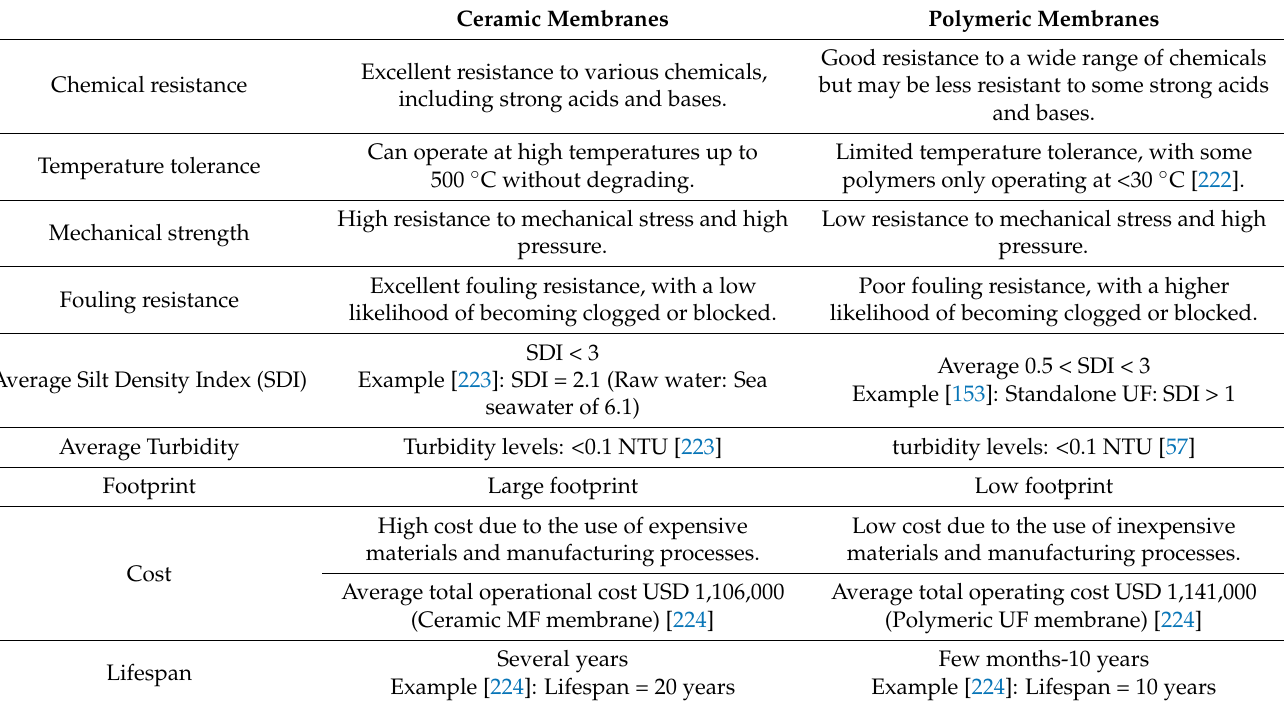
Table 9. Comparison table of ceramic and polymeric membranes, showcasing their main advantages and drawbacks. Ceramic Membranes Polymeric Membranes Good resistance to a wide range of chemicals Excellent resistance to various chemicals, but may be less resistant to some strong acids Chemical resistance including strong acids and bases. and bases. Limited temperature tolerance, with